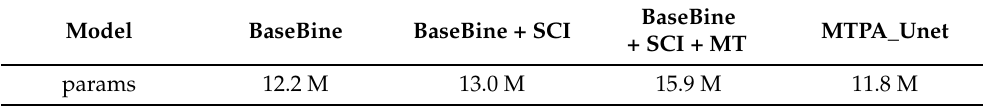
Table 8. Comparison of the number of parameters of each ablation structure network